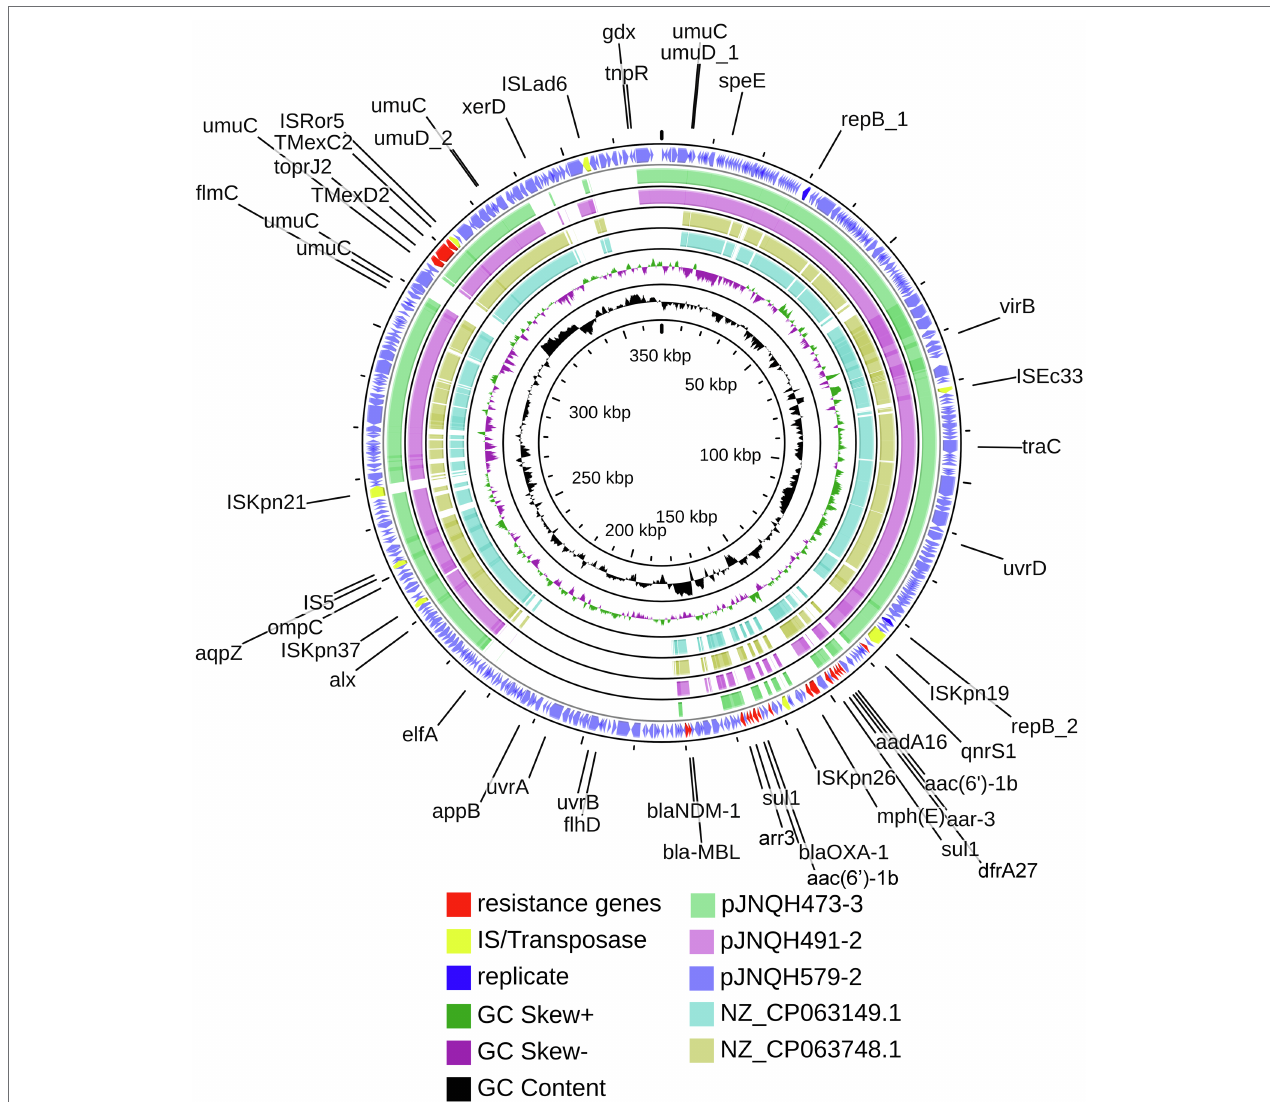
FIGURE 1 | Comparative structural analysis of pJNQH473-3, pJNQH491-2, pJNQH579-2, and two TmexCD2-ToprJ2 harboring plasmids NZ_CP063149.1 and NZ_CP063748.1. Open reading frames (ORFs) of pJNQH579-2 are shown as the outermost ring, with plasmid replicons, insertion sequences (IS), and antimicrobial resistance genes